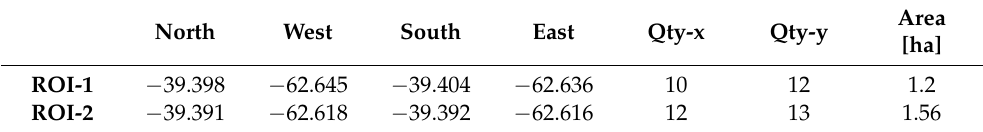
Table 1. ROI boundaries in geographic coordinates (WGS84), x-pixels quantity (Qty-x), y-pixels quantity (Qty-y), and ROI area selected for training the MOGP models with the S1 & S2 dataset. ROI-1 belongs to the winter wheat 2020 site whereas the ROI-2 to 2021 site.